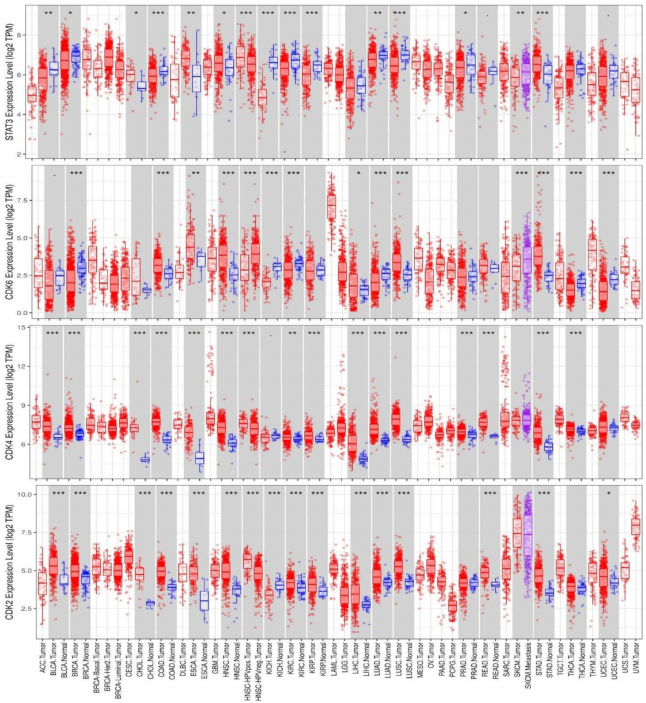
Figure 1. STAT3/CDK2/4/6 are overexpressed in multiple cancers. Box plots showing differential gene expression levels (Log2 TPM) of STAT3/CDK2/4/6 between tumor and adjacent normal tissues across TCGA database. Blue labels indicate normal tissues, and red labels indicate tumor samples. The statistical significance of differentially expressed genes was evaluated using the Wilcoxon test. * p < 0.05; ** p < 0.01; *** p <